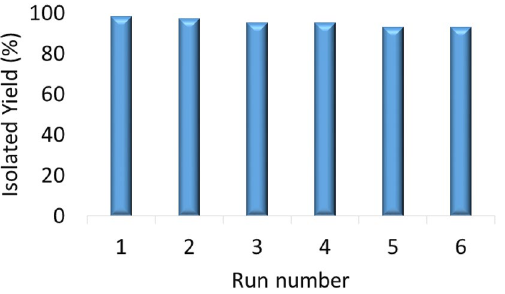
Figure 9. Recyclability of Cu(II)-MP-bis(AMP)@boehmite in the coupling of phenol with iodobenzen.